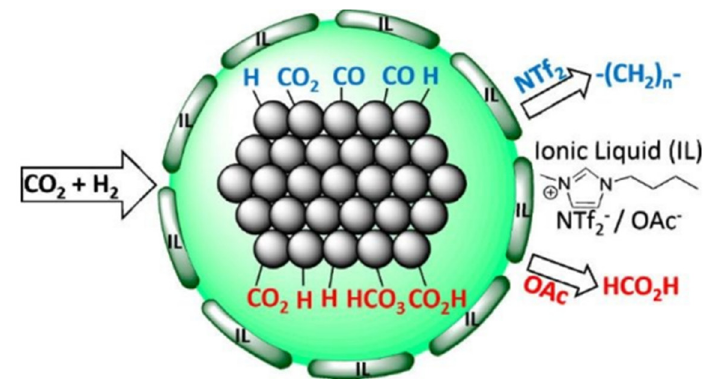
Figure 4. IL cage on RuFe nanocatalysts for CO 2 to HCOOH (basic IL) selective hydrogenation using hydrocarbons (via non-basic IL). With Permission from Ref. [83]. Copyright 2018, American using hydrocarbons (via non-basic IL).With Permission from Ref. [83]. Copyright 2018, American Chemical Chemical Society.